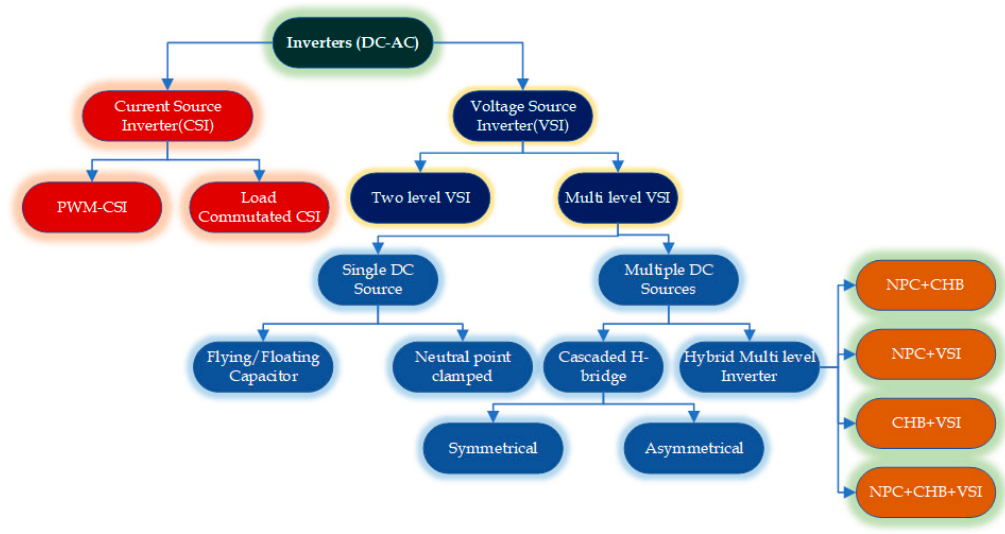
Figure 1. Classification of MLI .